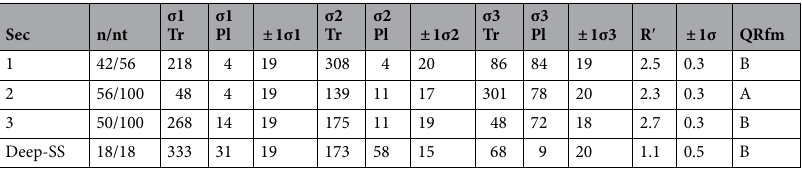
Table 2. Stress inversion parameters σ1, σ2, σ3, and R ′ are computed for sectors 1, 2, and 3 starting from the FMS-Catalog and the collected focal mechanism solutions. Key: Sec. = sector; n/nt = number of inverted FMs with respect to the total number of data; σx Tr. = trend of σ1, σ2, σ3 axes; σx Pl. = plunge of σ1, σ2, σ3 axes; 1 σ = 1 σ standard deviation; QRfm = quality factor as in the World Stress Map 5 . R ′ = R for normal